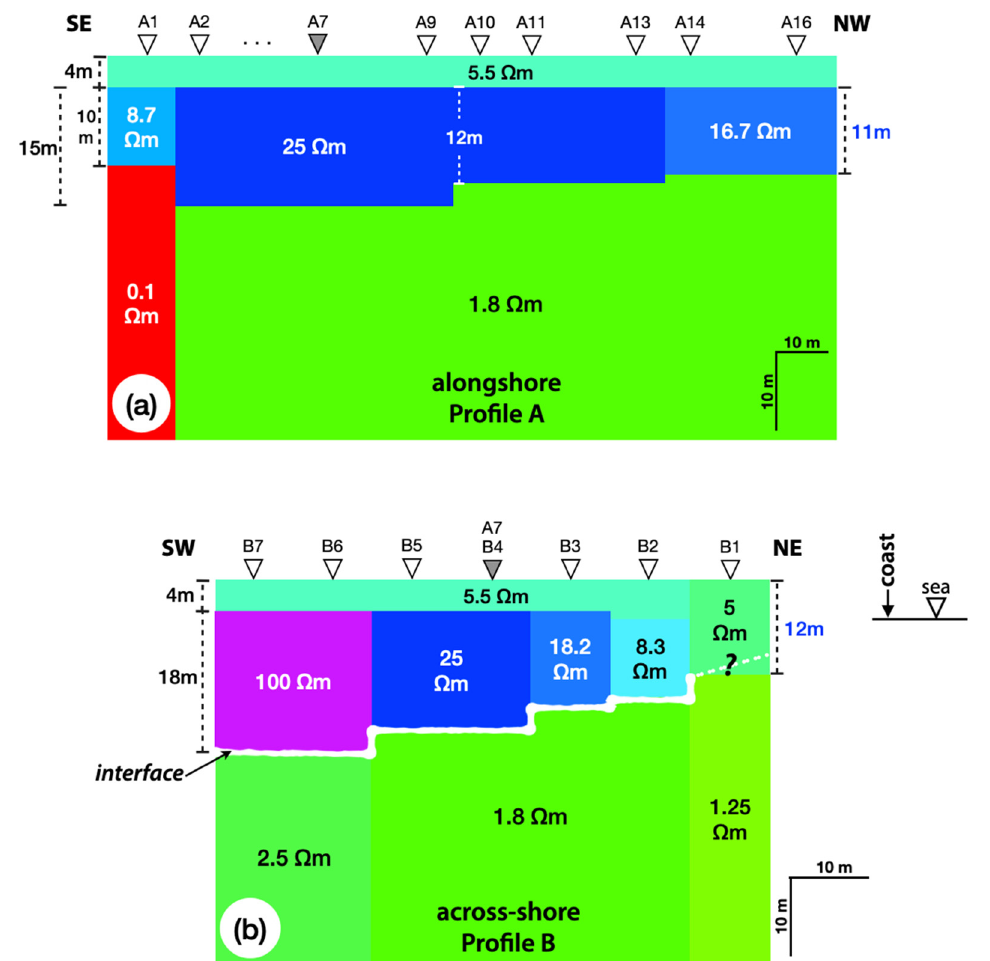
Figure 9. Stitched version of resistivity profiles obtained from 1D forward modeling results of the 2018 ( a ) alongshore Profile A and ( b ) across-shore Profile B surveys. The white line provides a rough guide to the geometry of the thinning of the freshwater lens towards the coast, where it becomes mildly brackish to mildly saltwater.